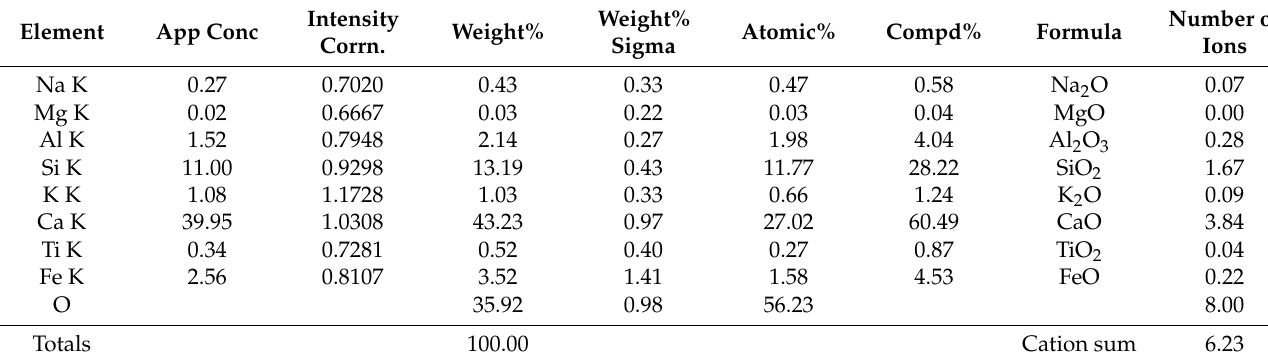
Figure 18. EDS analysis for belite crystal of point “ Spectrum 3 ” of Figure 15. Table 10. EDS analysis for belite crystal of point “ Spectrum 3 ” of Figure 15.